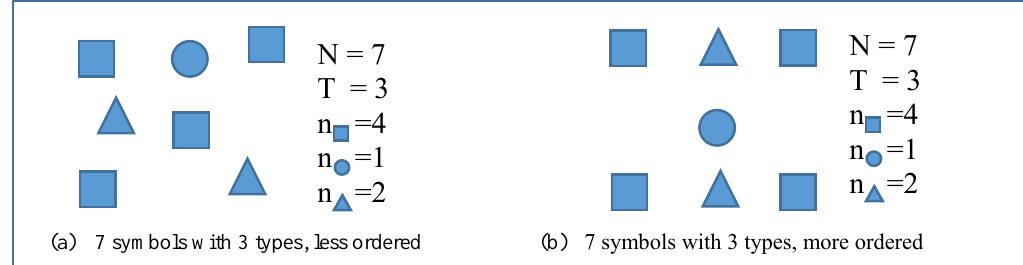
Fig. 2 Two maps with different distributions of symbols but same amount of Shannon entropy (i.e. H=0.415)